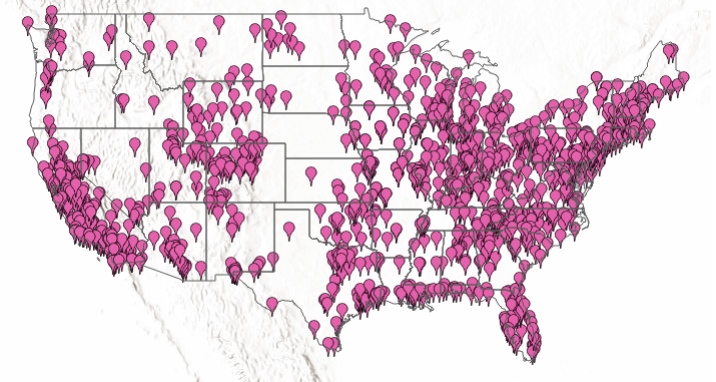
Figure 3. Positions of sensors, which collect information about SO 2 . Source: epa.gov/outdoor-air- quality-data/interactive-map-air-quality-monitors. Table 3. Description of the EPA database 28